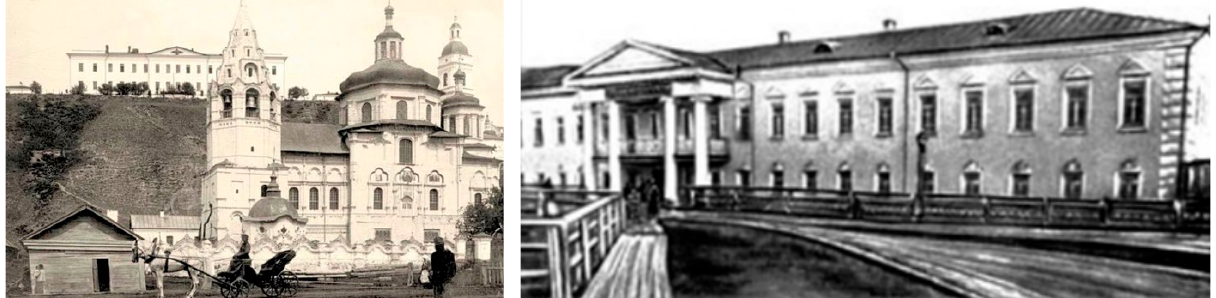
Figure 2. Tobolsk at the end of XIX century: left - the Bogoyavlensky church were Mendeleev was baptized; right - the gymnasium where